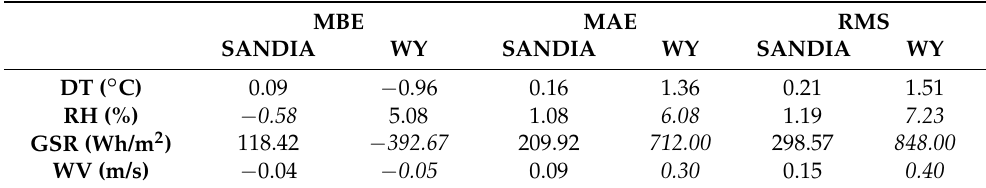
Table 11 . Summary comparative study for the Santiago EOAS station (period 2008–2017). MBE